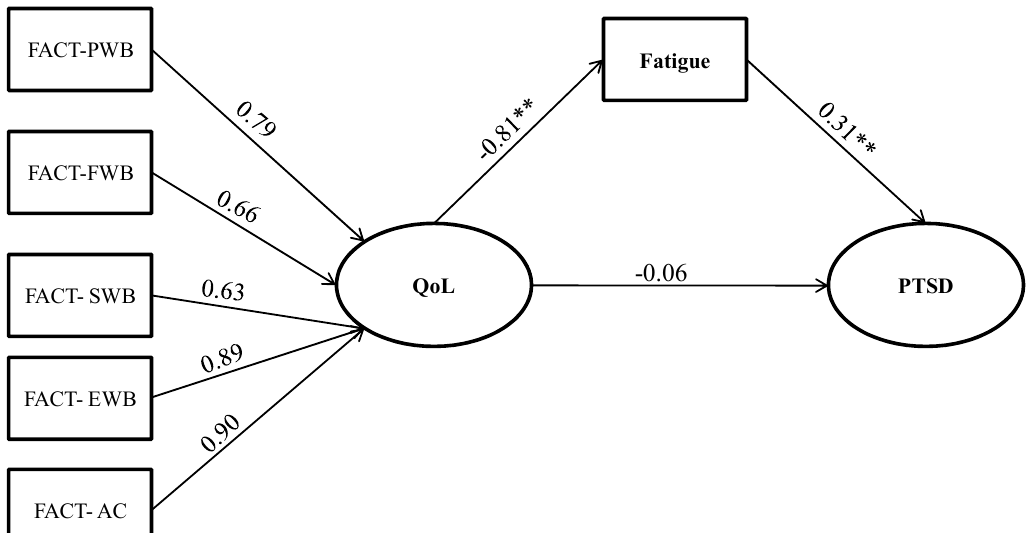
Figure 1. The mediation of PTSD symptoms. Note: Fact PWB: domains of well-being: physical; FWB: domains of well-being functional; SWB: domains of well-being social; EWB: domains of well-being emotional; AC: additional concerns; PTSD: Post Traumatic Stress Disorder; QoL: Quality of life; Path values are the path coefficients (standard errors). ** p < 0.01.